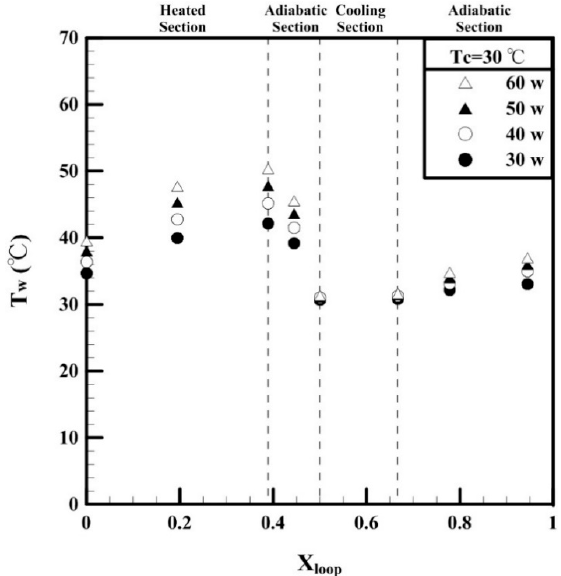
Figure 3. Steady-state temperature distribution of the wall of the loop with different heating powers.